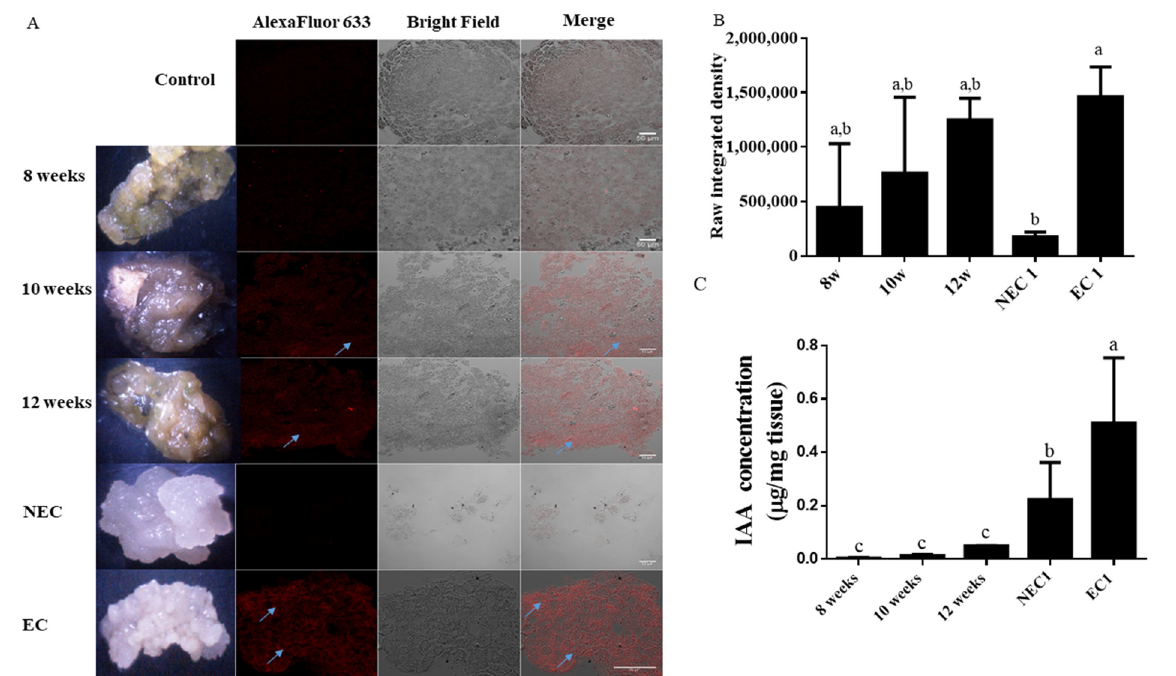
Figure 2. IAA assays in time courses from leaf segment induction. NEC and EC are non-embryogenic and embryogenic calli , respectively, similar to EC 1 and NEC 1 represented in Figure 1. ( A ) Immunohistochemistry observations. Fluorescence, transmission, and composed image of the different tissues, unlabeled tissue samples from EC were used as control (C—control; 8 w—8 weeks induction; 10 w—10 weeks induction; 12 w—12 weeks induction; NEC—non-embryogenic callus ; EC—embryogenic callus ). ( B ) Raw integrated intensity for each sample. ( C ) IAA quantification by HPLC. Results are presented as mean ± SD. Different letters are significantly different according to Tukey test ( p < 0.05).